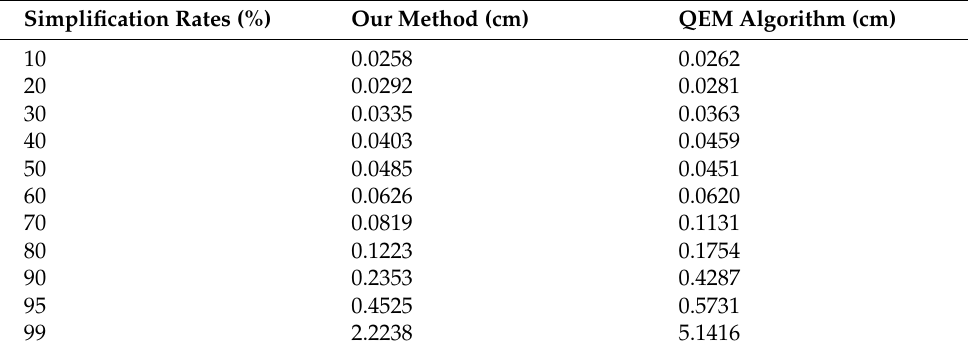
Table 1. Quantitative comparison of our method and the QEM